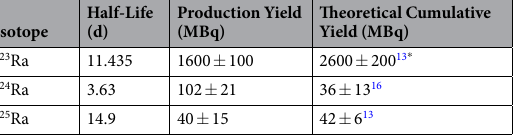
Table 1. Production Yields of 223, 224, 225 Ra from a 10 g 232 Th target (90 MeV, 230 µ A, 22.5 h, 640 mg/cm 2 ). * Includes yield from decay of 227 Th.